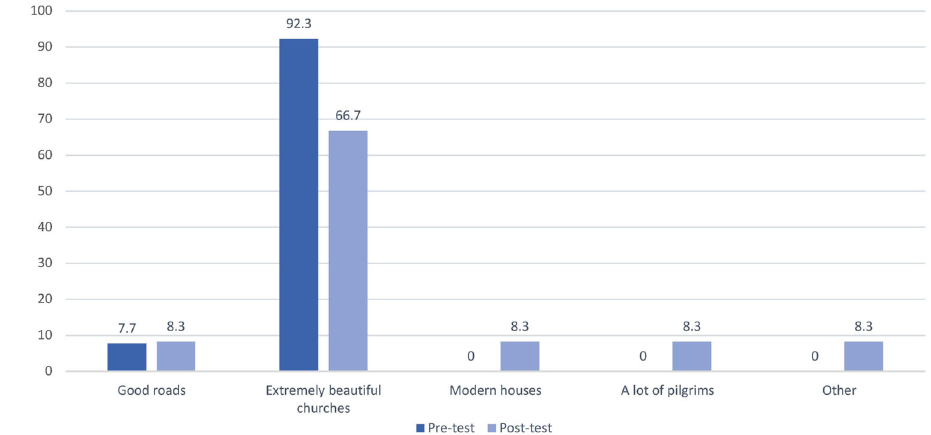
Fig. 12 School community. What is the most important thing in New